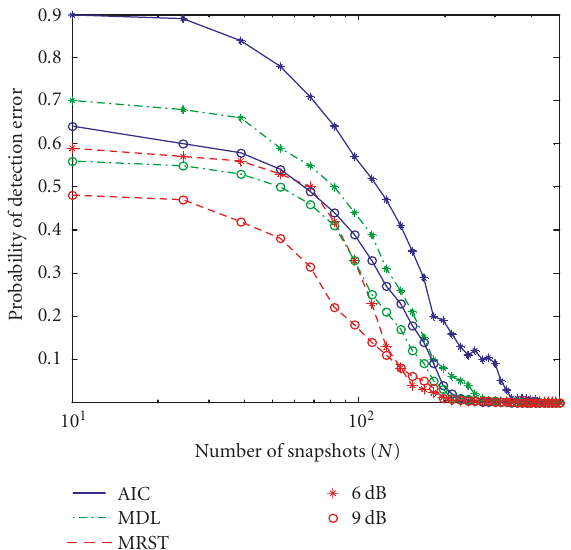
Figure 14: Probability of error versus the number of snapshots for the AIC, MDL, and multiresolution sphericity test in (14)